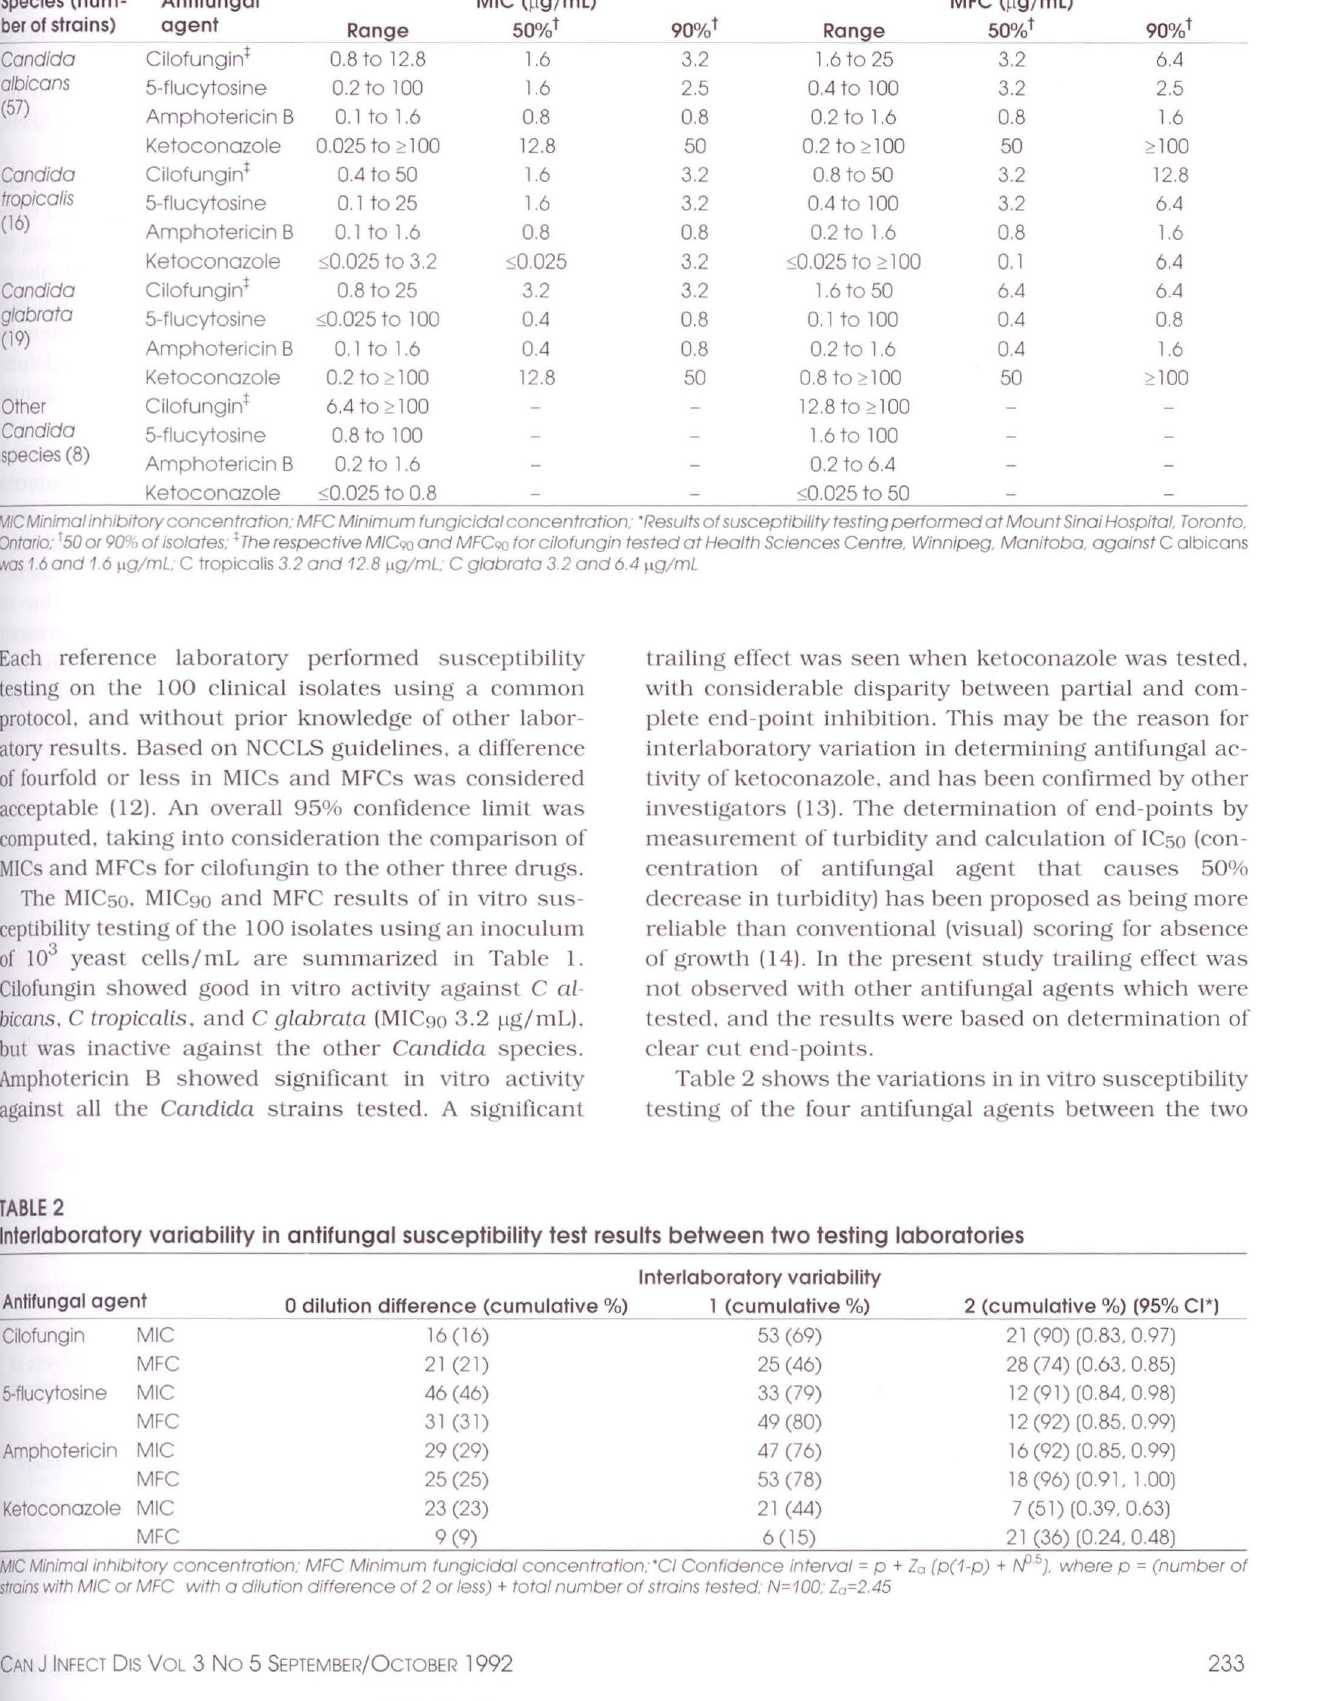
Interlaboratory variability in antifungal susceptibility test results between two testing laboratories Antifungal